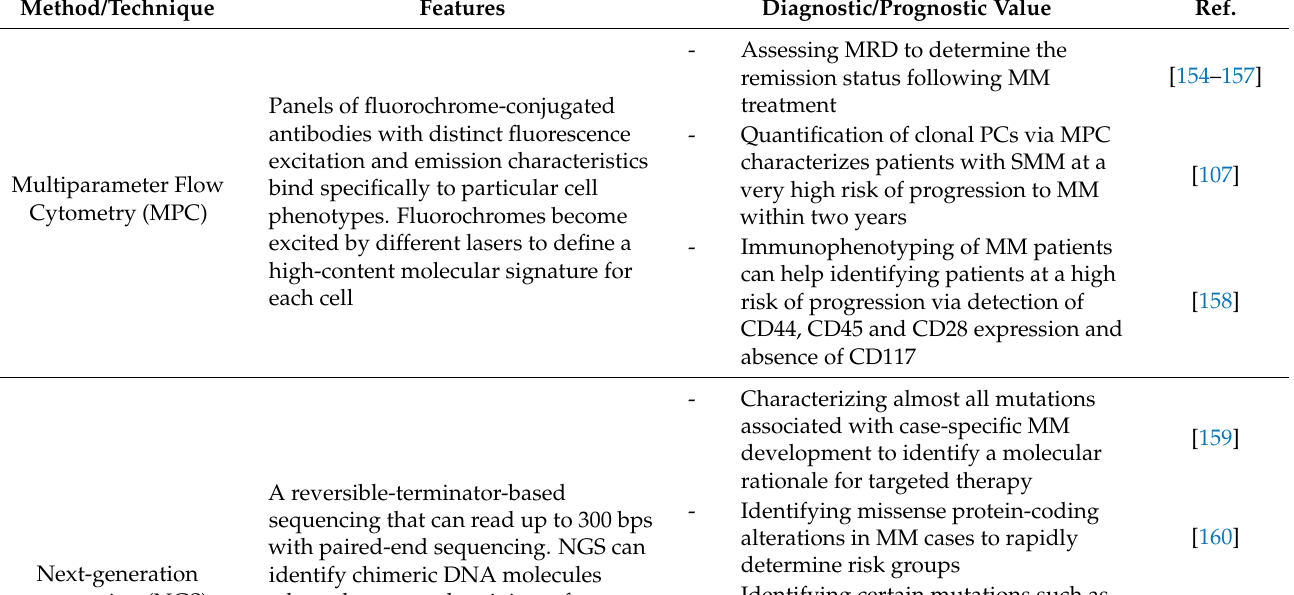
Table 4. Advanced methodologies and their potential roles in diagnosis and prognosis of MM.